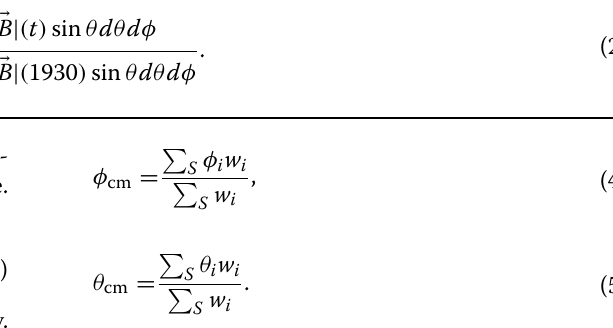
|� B | rel F out (2) as follows: min using